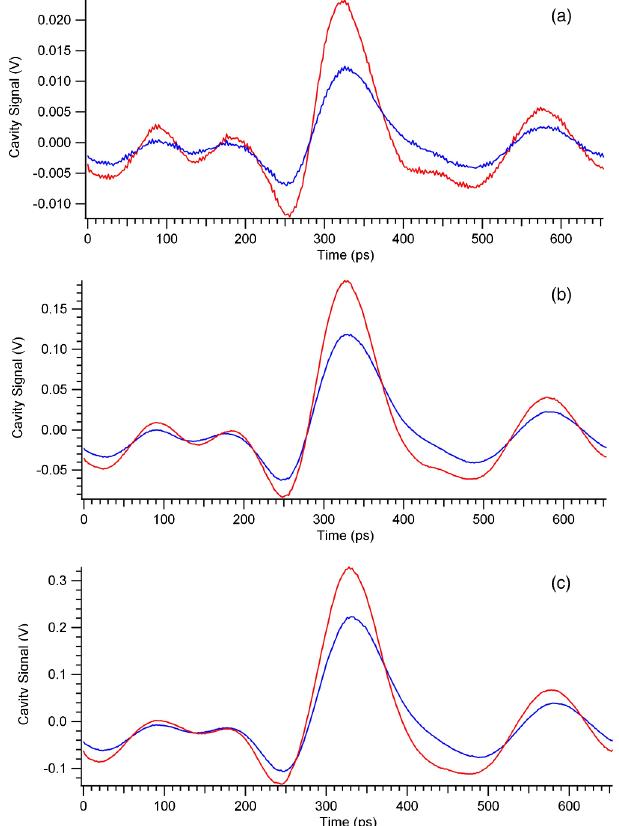
FIG. 6. Electron bunches from thin (100 nm) strained-layer superlattice GaAs/GaAsP photocathodes. The left side images show oscilloscope traces and the right side images show post- processed FFTs, for 75 kV bias voltage (b) and 175 kV bias voltage (d) at three currents.